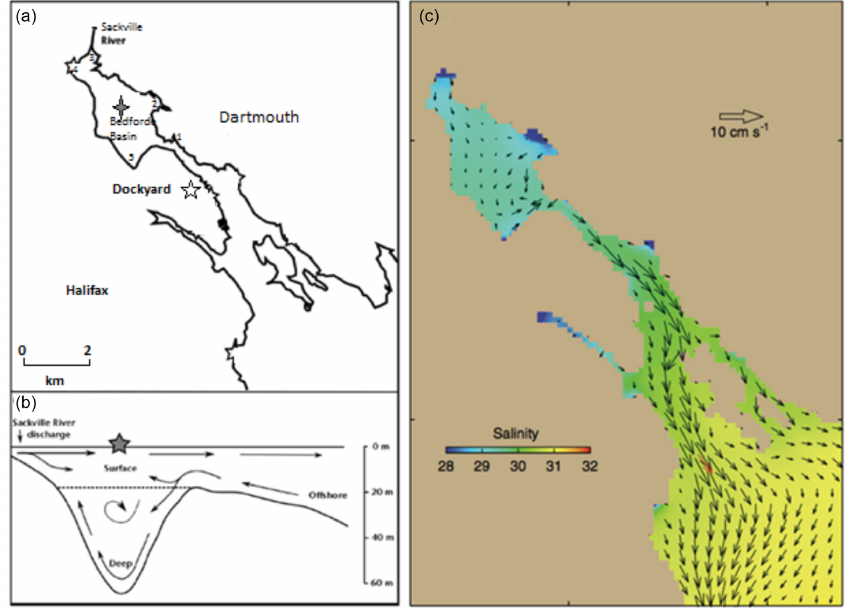
Figure 1. (a) Main sampling location (grey star) and nearshore sampling locations 1–5 (1: Tufts Cove; 2: Wrights Cove; 3: Sackville; 4: Mill Cove; 5: Fairview Cove) in Bedford Basin; (b) two-layered flow in Halifax Harbour adapted from Kerrigan et al. (2017); (c) horizontal circulation of water in Halifax Harbour from Shan et al. (2011) using annual mean currents and